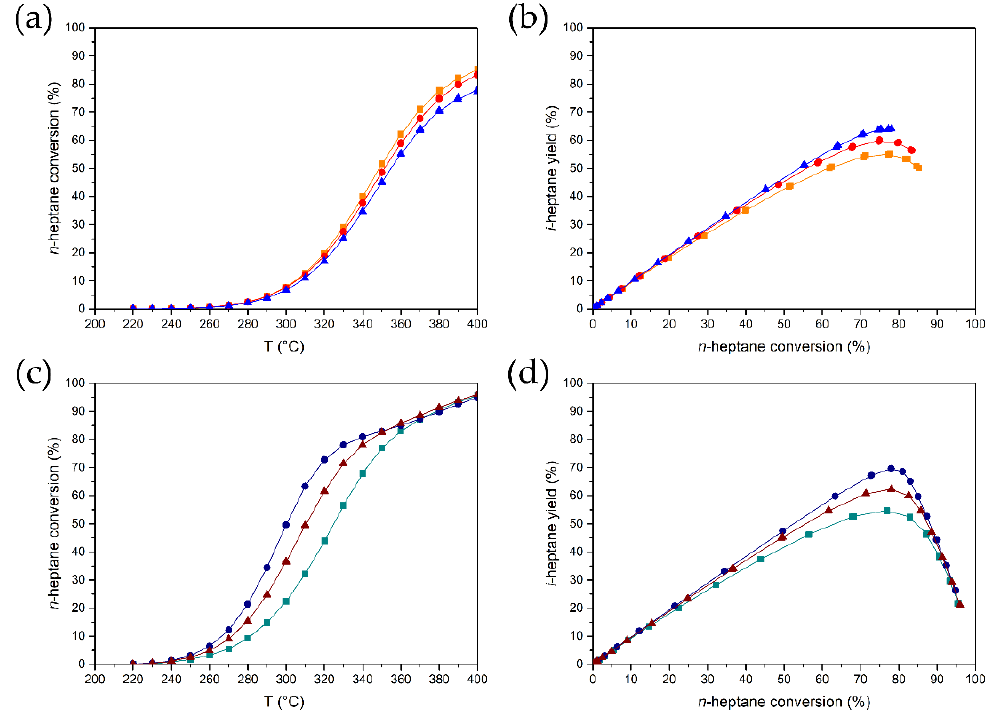
Figure 4. Results of the hydroconversion of n -heptane. ( a ) n -heptane conversion as function of the temperature and ( b ) i -heptane yield as function of the n -heptane conversion for Pd-SAPO-11/ γ - Al 2 O 3 CR (orange squares), Pd- γ -Al 2 O 3 /SAPO-11 (red circles) and Pd-SAPO-11/ γ -Al 2 O 3 DR (blue triangles). ( c ) n -heptane conversion as function of the temperature and ( d ) i -heptane yield as function of n -heptane conversion for Pd-ZSM- 22/γ -Al 2 O 3 CR (cyan squares), Pd- γ -Al 2 O 3 /ZSM-22 (dark blue circles) and Pd-ZSM- 22/γ -Al 2 O 3 DR (brown triangles).